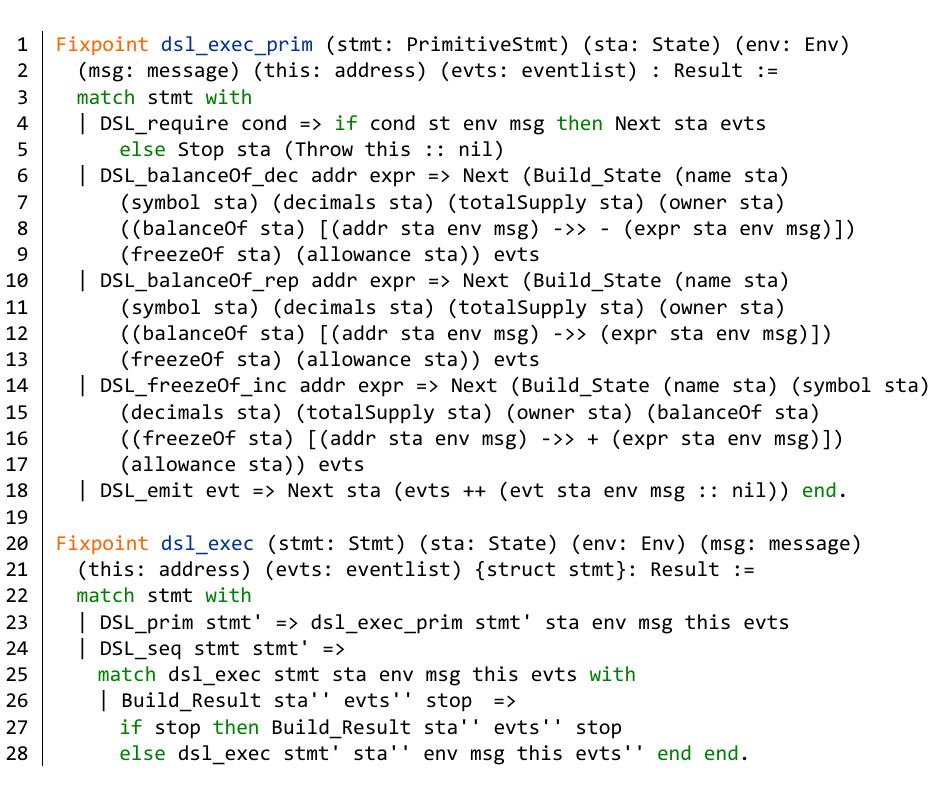
Figure A1. Semantics of DSL statements.